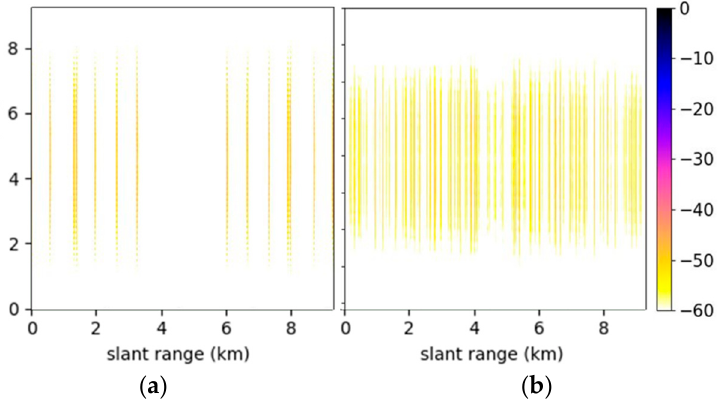
Figure 10. Focused SAR images for ( a ) 𝑁 = 5 and ( b ) 𝑁 = 13 showing the smearing of the nadir echo for a point scatterer. All data are displayed in dB. Table 3. Sets of 𝑡 (cid:3036) values (normalized by 𝜏 ) with the best nadir echo suppression performance for primes 𝑁 between 5 and 17.